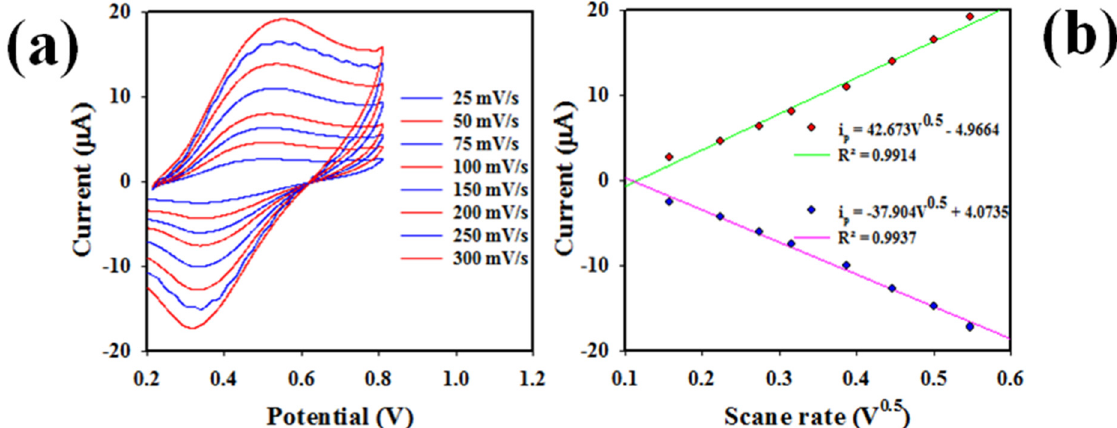
Figure 9. ( a ) Cyclic voltammetric analysis of UA at a range of concentrations (0.15–1.35 mM) in 7.0 pH buffer solution in presence of 0.6 mM K 3 Fe (CN) 6 (0.1M PBS), and ( b ) calibration of UA sensor based on the analysis of CV, where peak oxidation and reduction currents are collected from Figure 7a.